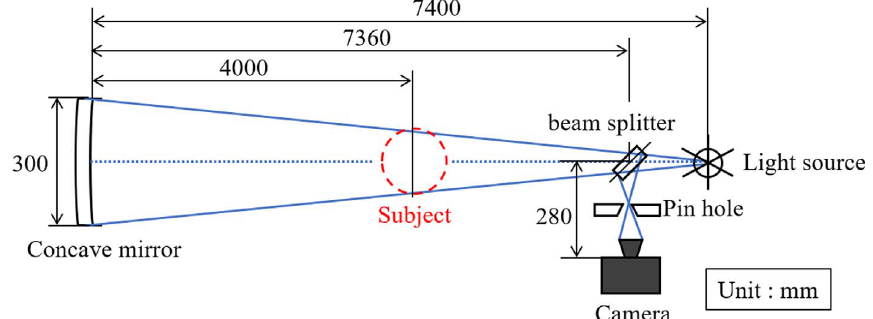
Figure 5. Experimental setup for Schlieren method.